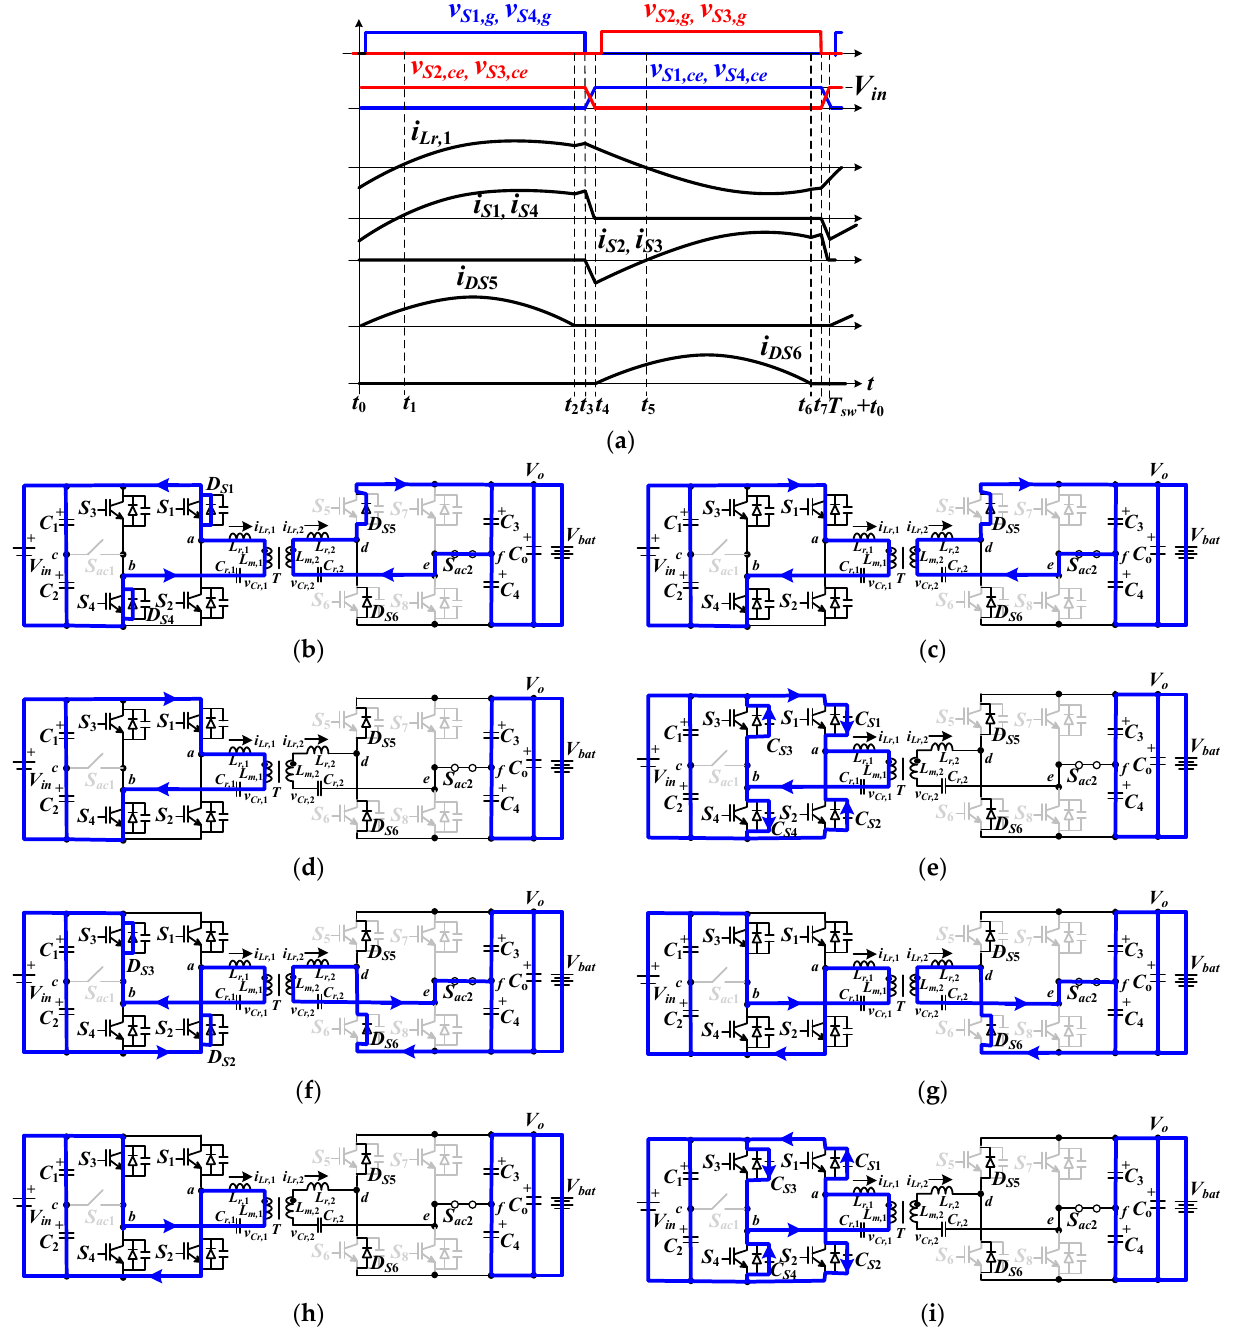
Figure 2. PWM signals and state circuits under low voltage range input and forward power flow: ( a ) PWM signals; ( b ) State 1; ( c ) State 2; ( d ) State 3; ( e ) State 4; ( f ) State 5; ( g ) State 6; ( h ) State 7; ( i ) State 8.